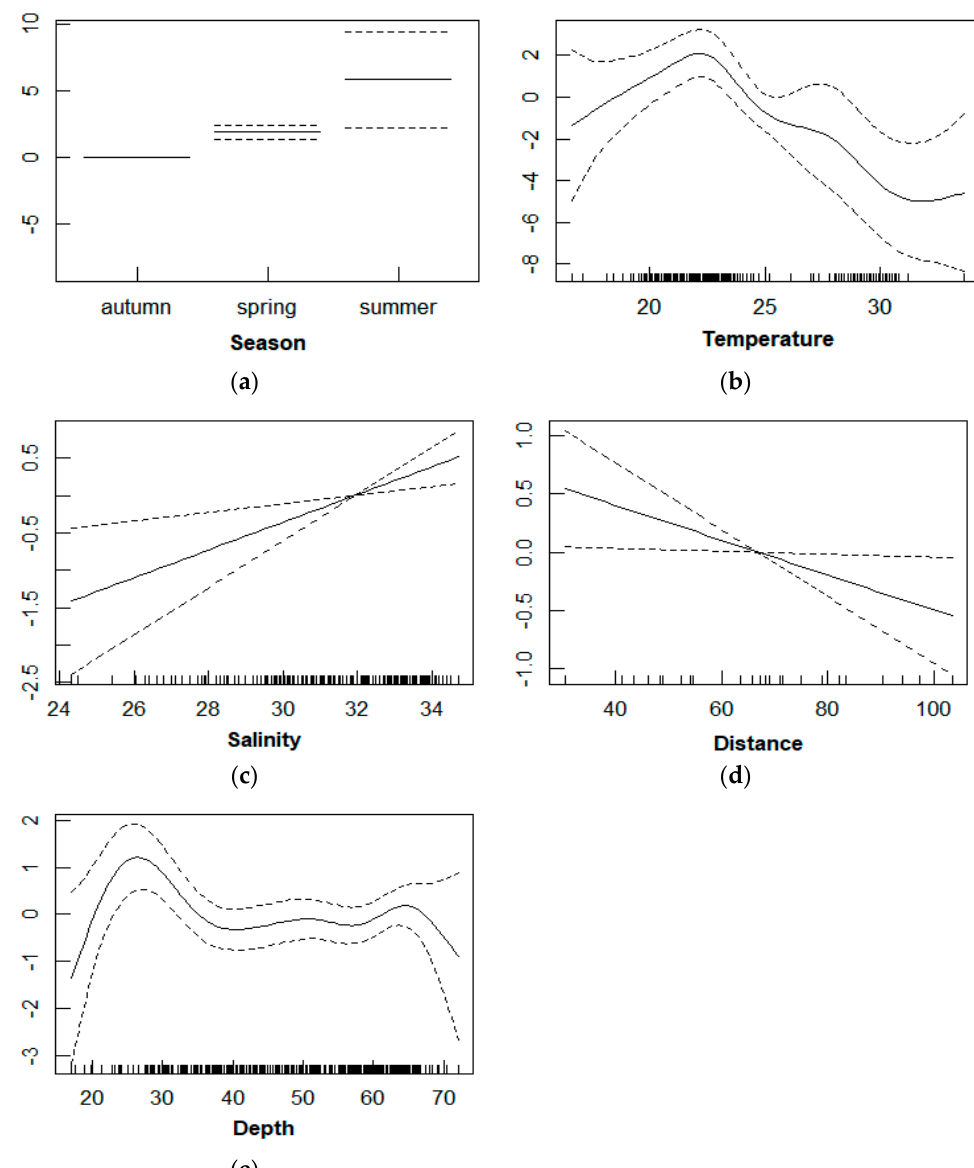
Figure 4. Relationship between the density of D. maruadsi and environmental factors in coastal wa- ters of southern Zhejiang at seasonal scales (Autumn): ( a ) effect of depth; ( b ) effect of temperature; ( c ) effect of salinity; and ( d ) effect of latitude. Dashed lines show 95% confidence intervals.